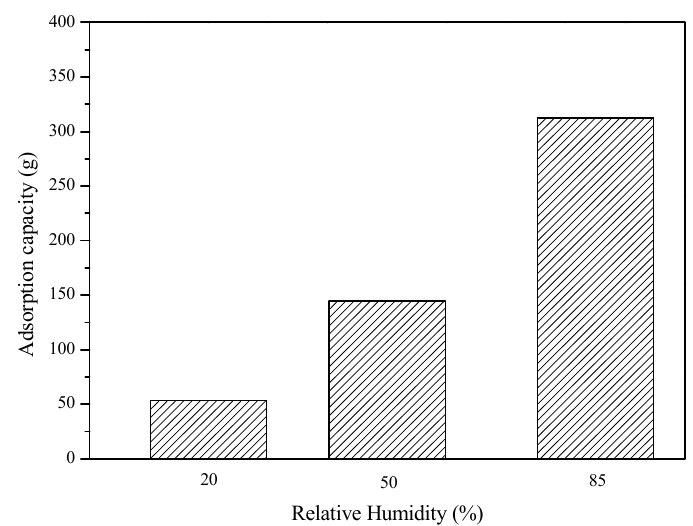
Figure 5. The total amount of adsorption for 1 h at various relative humidity levels of air at an ambient temperature of 15 ◦ C and a flow rate of 90 m 3 /h.